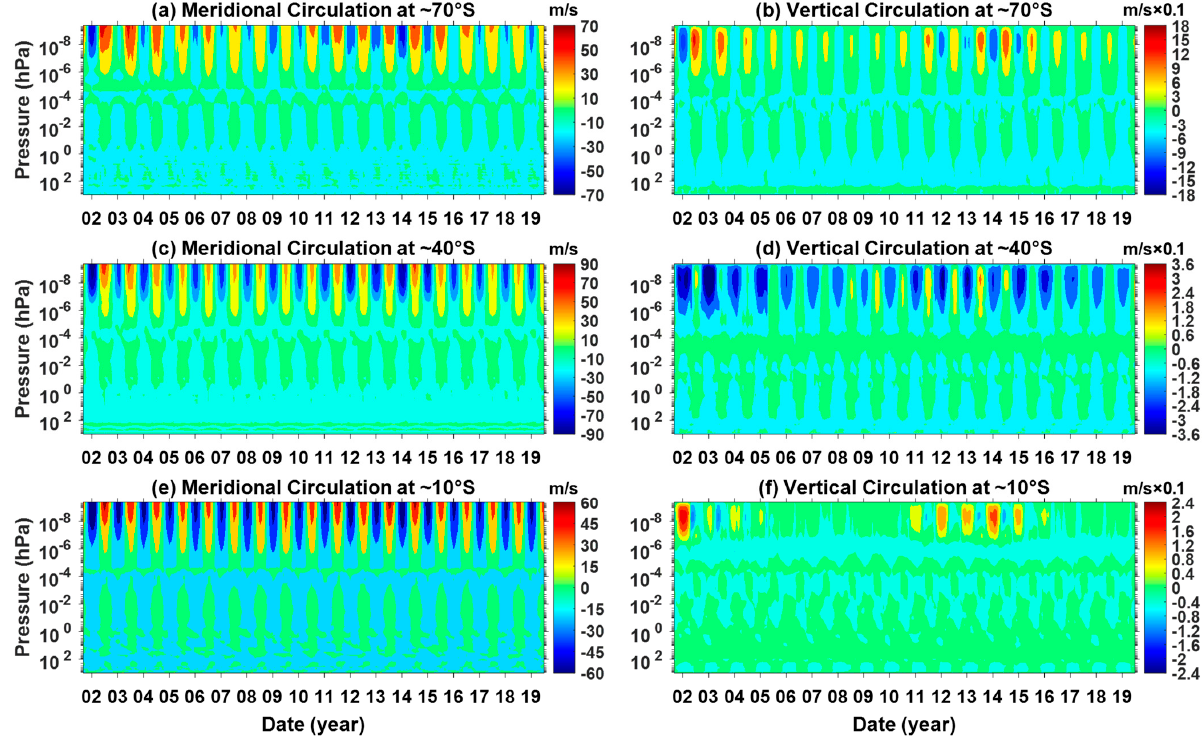
Figure 3. Temporal variations in the ( a , c , e ) meridional circulation and ( b , d , f ) vertical circulation at ( a , b ) ~70° S, ( c , d ) ~40° S, and ( e , f ) ~10° S.